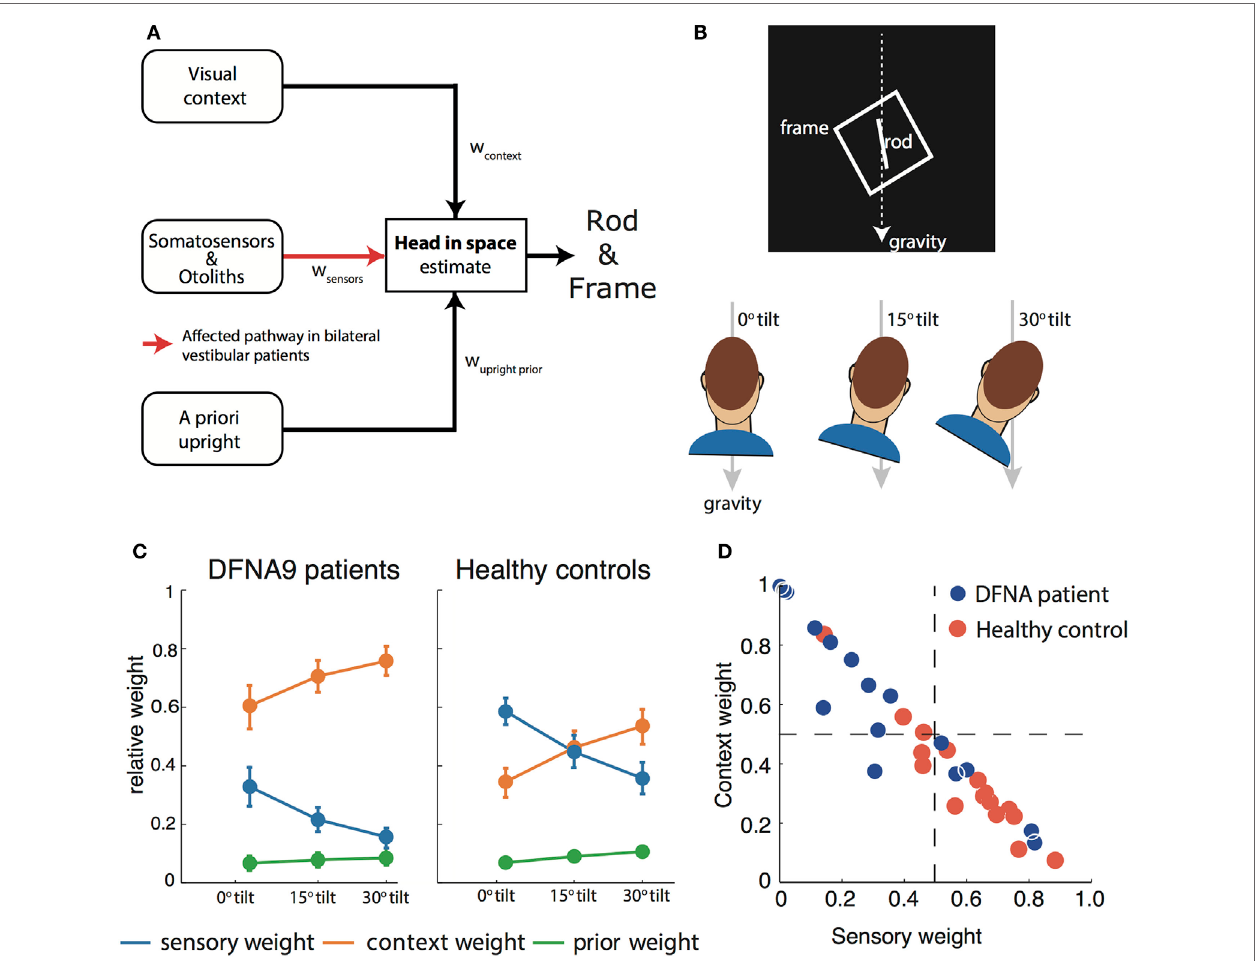
FigURe 2 | (A) Schematic of the Bayesian optimal integration model as proposed in Alberts et al. (21, 55) for the rod-and-frame effect. In the rod-and-frame task, an estimate of head orientation in space is used that is derived from visual context information, sensory information from somatosensors in the body, and otoliths in the head. In addition, the brain assumes that upright positions are more likely based on prior experience. Each of these information streams is weighted into the head-in-space estimate based on its reliability. (B) Schematic of the rod-and-frame task. The subject views a rotated frame in which an oriented line is shortly flashed. He/she must indicate whether this line is rotated clockwise or counterclockwise relative to gravity, using a two-alternative forced choice response. Subjects performed this task under three head orientations (0°, 15°, and 30°). (C) Weights attributed to the various sources for bilateral vestibular patients and healthy controls. Notice that the patients rely much more (factor 2–3) on the visual contextual information than the controls. (D) Weighting of sensory information, lumped from somatosensors and otoliths, and contextual information of the frame to estimate the head orientation in space for the individual patients and